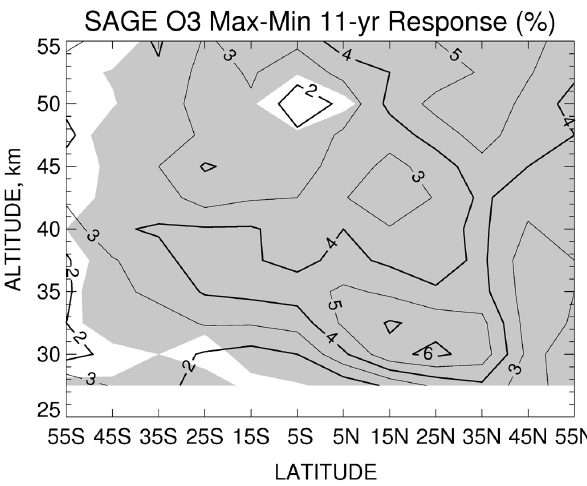
Fig. 7. Contour plot of the phase variations (in years from January 1991 or 2002) of the 11-yr response terms of Figure 6. Contour interval is 1 year. The phase domain of ± 1 year is shaded and is considered as in-phase with the solar uv-flux